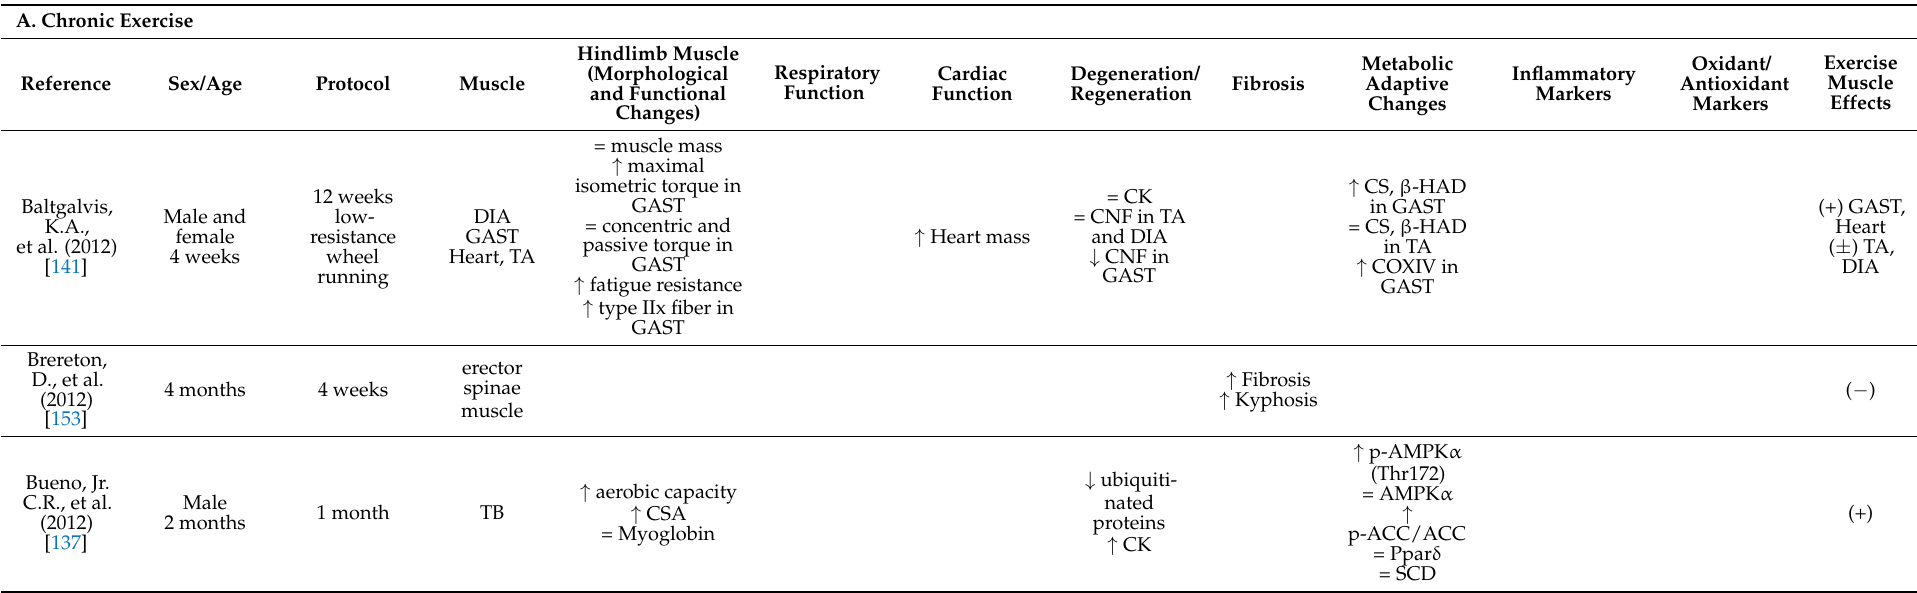
Table A4. Effects of voluntary wheel running on mdx mouse